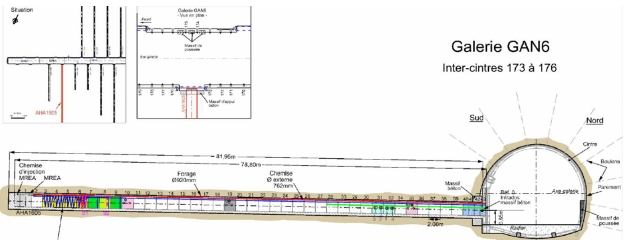
Fig. 10. Full-scale Emplacement (FE) Experiment at the Mont Terri URL